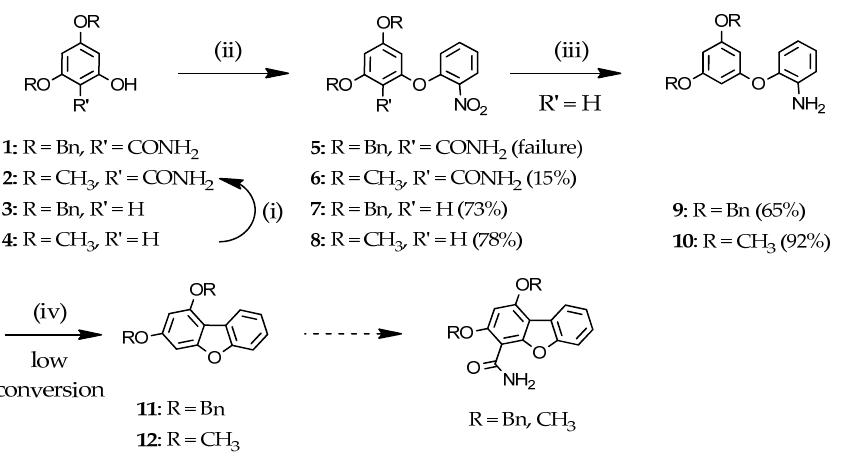
Figure 2. Proposed synthetic strategies to obtain the dibenzo[ b , d ]furan